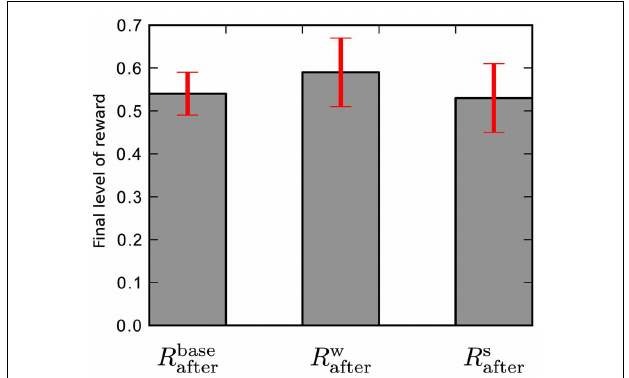
FIGURE 5 | Reward traces showing the running average ¯ R (only every 50th point plotted) for different weight resolutions averaged over 20 runs. (A) Baseline performance with continuous weights. Additionally, the light gray trace shows the reward R for every trial of a single simulation. (B) Performance with 8bit resolution. The lower plot shows the difference to the baseline model in (A) . The shaded area shows the difference for every point in the trace instead of only for every 50th. (C) Performance with 6bit resolution. (D) Performance with 4bit resolution. The black trace shows the result for deterministic updates. The green trace for probabilistic updates. Table 3 | Comparison of simulations with different hardware constraints.